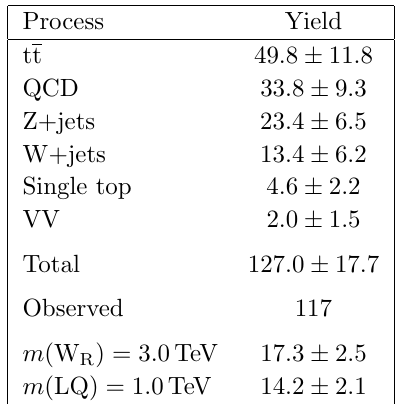
Table 2 . Estimated background and signal yields in the SR and their total uncertainties. The expected number of events for the W R signal sample assumes m (N